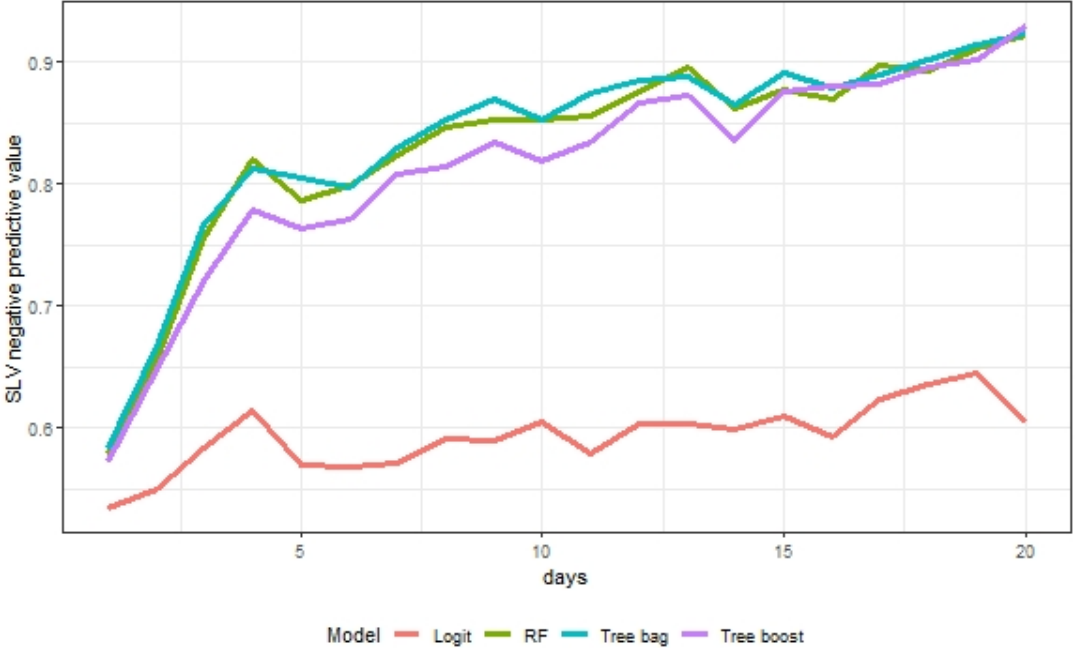
Figure 11. This figure shows the multi-period negative predictive value for SLV price direction. One concern about predicting stock price direction is that the usual machine learning approach of randomly splitting the data set into training and testing parts may not be representative of time series forecasting in practice. The question arises as to how to deal with serial correlation. Bergmeir et al. (2018) show that in autoregressive models k-fold cross validation is possible so long as the errors are uncorrelated. In the approach taken in this paper, the forecast variable is gold or silver ETF price direction (which is a classification rather than regression) and the features are technical indicators, some of which (like the MA200) embody a lot of past information on stock prices that helps to mitigate the